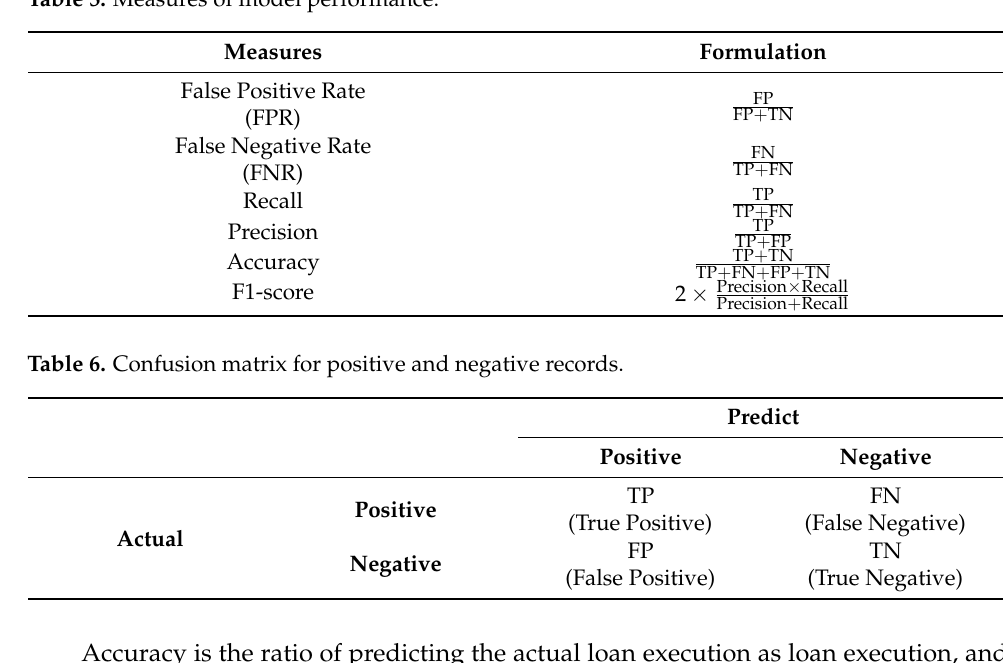
Table 5. Measures of model performance.